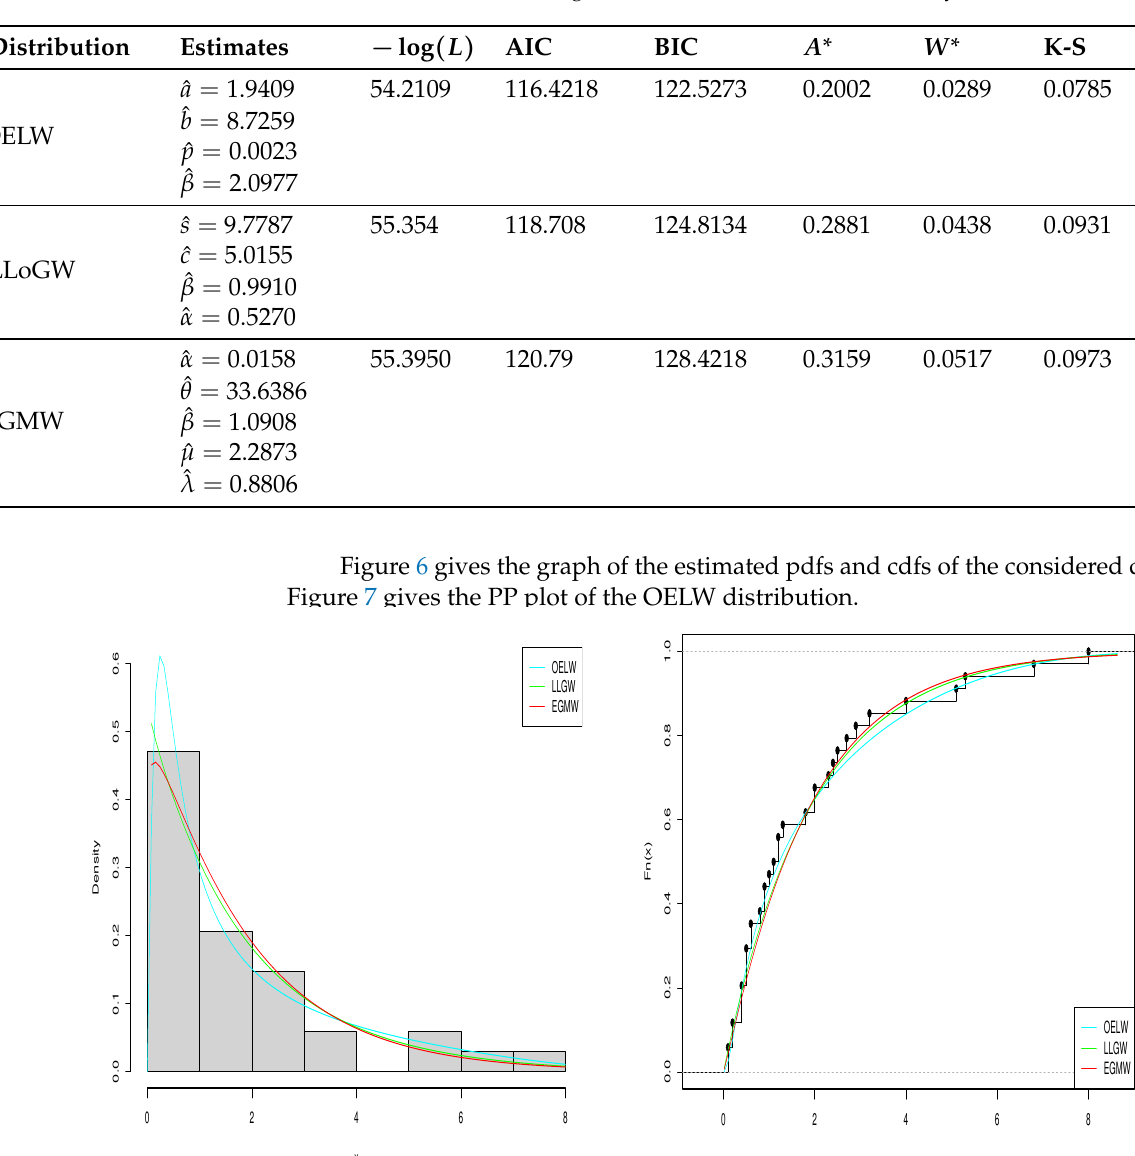
Table 6. Estimated values, log-likelihood, AIC, and BIC for the vinyl chloride data set.